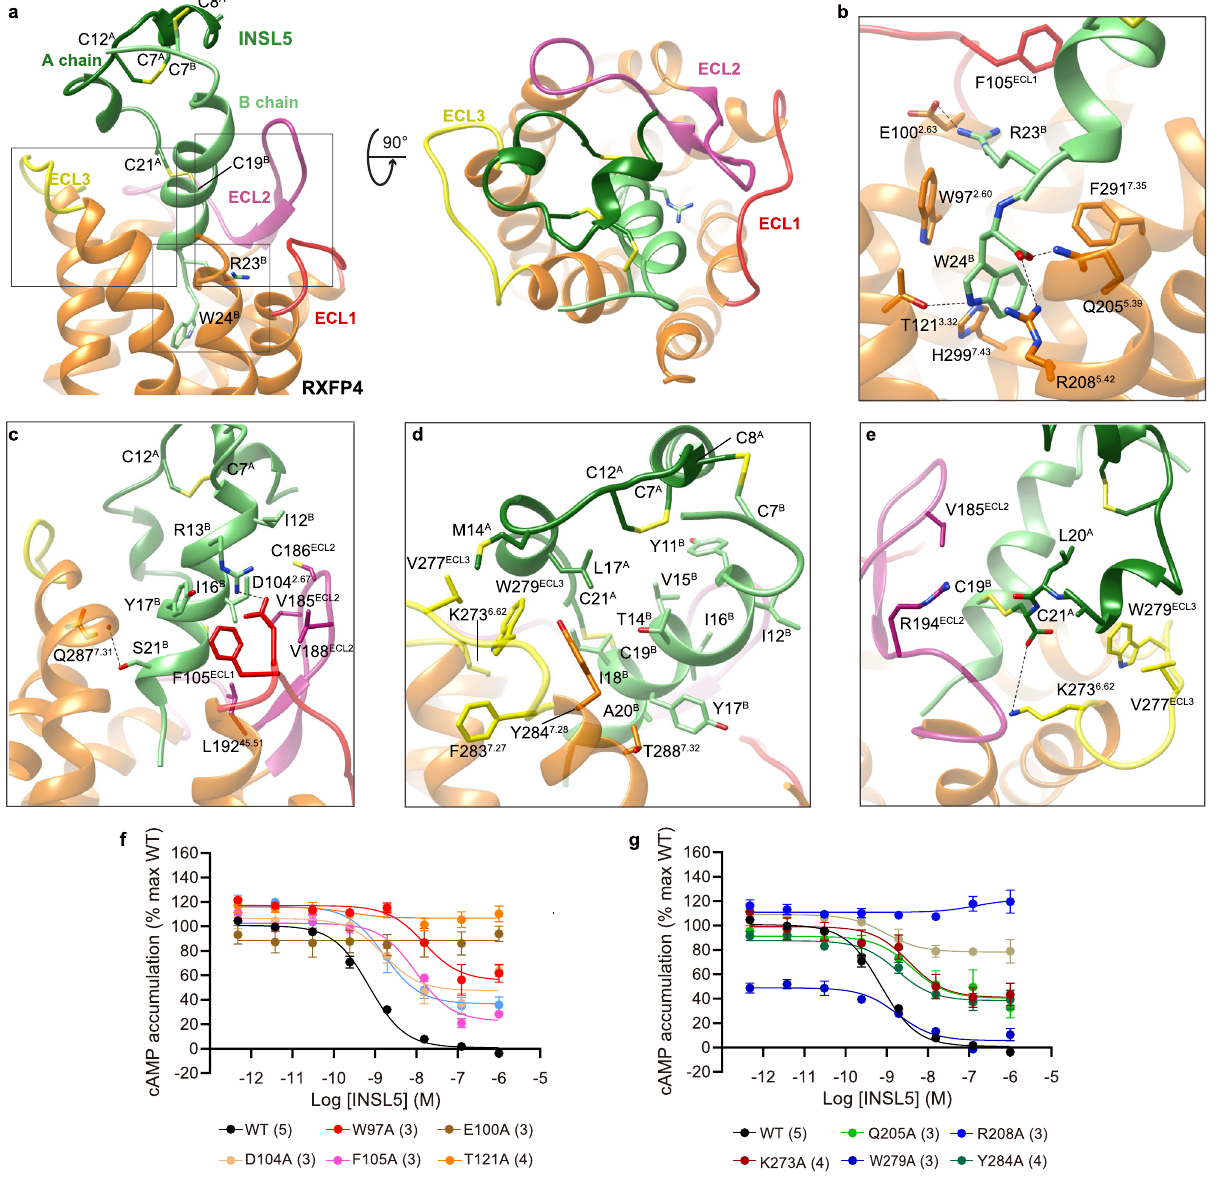
Fig. 2 | Molecular recognition of INSL5 by RXFP4. a Binding mode of INSL5 (green) with RXFP4 (orange), showing that the B chain of INSL5 (light green) penetrates into the transmembrane domain (TMD) bundle using the C-terminal α - helix, whereas the A chain of INSL5 (forest green) covers the orthosteric pocket mainly interacting with the extracellular loops 2 (ECL2, violet red) and 3 (ECL3, yellow). b Interactions of R23 B and W24 B with RXFP4 in the orthosteric pocket. c – e Close-up views of the interactions between the B chain of INSL5 and the